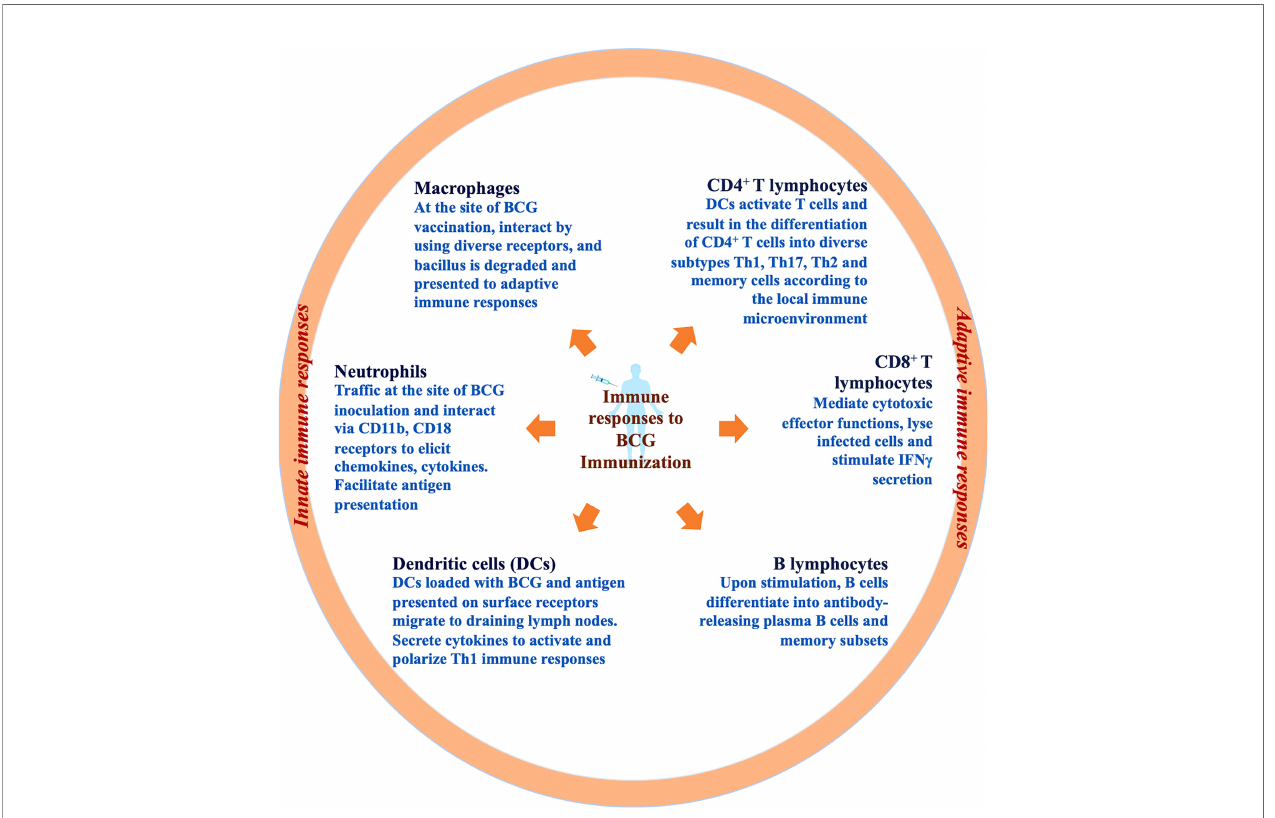
FIGURE 1 | Immune responses to BCG immunization. Immune responses to the BCG vaccine initiate at the site of inoculation by induction of innate immune cells such as resident macrophages, neutrophils, and dendritic cells. Innate immune cells internalize, degrade and present antigen of bacilli via surface receptors to further activate adaptive immune cells. Chie fl y, DCs loaded with bacilli drain to the lymph nodes and result in lymphocyte stimulation and activation. T and B lymphocytes further differentiate into diverse subtypes including effector and memory